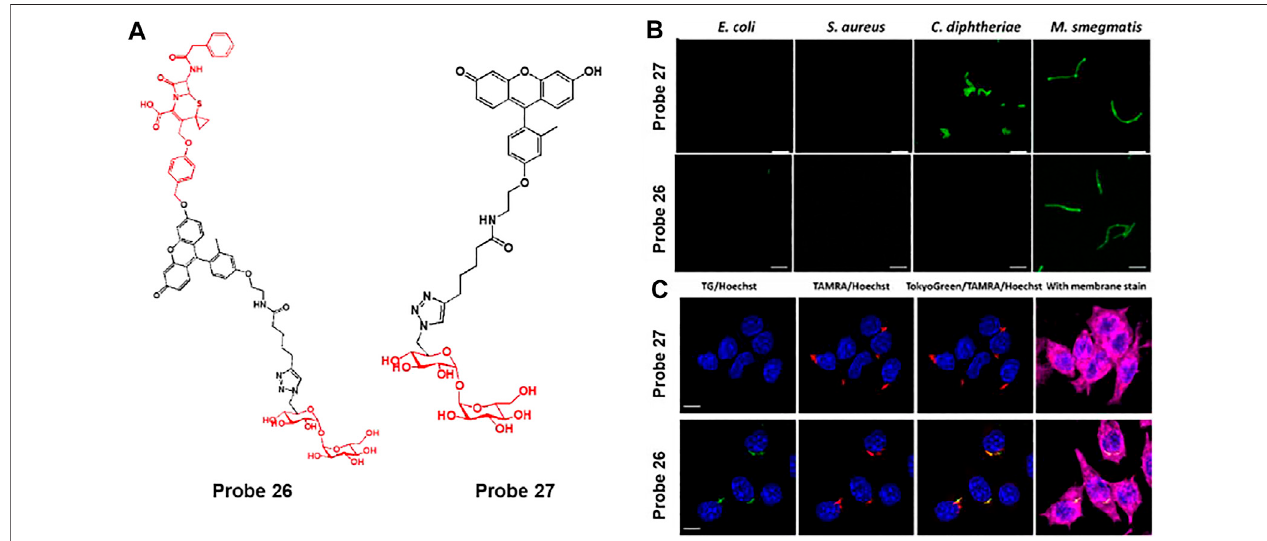
FIGURE14|(A) Chemicalstructuresofprobes26and 27. (B) Confocal microscopy imagesofbacteriaincubated with50 μ Mofprobes 27and 26inPBSat 37 ° C for 2 h. Ex (cid:1) 490 nm/Em (cid:1) 520 nm. (C) Phagocytosed BCG cells were post-labeled by probes 26 and 27 (10 μ M) and imaged with a super-resolution structured illuminated microscope. Blue (cid:1) Hoechst; green (cid:1) probe; red (cid:1) TAMRA; deep red (cid:1) membrane stain. White arrows indicate the asymmetrical labeling of a single BCG. Reproduced with permission from Dai et al. (2020). Copyright © 2020, American Chemical